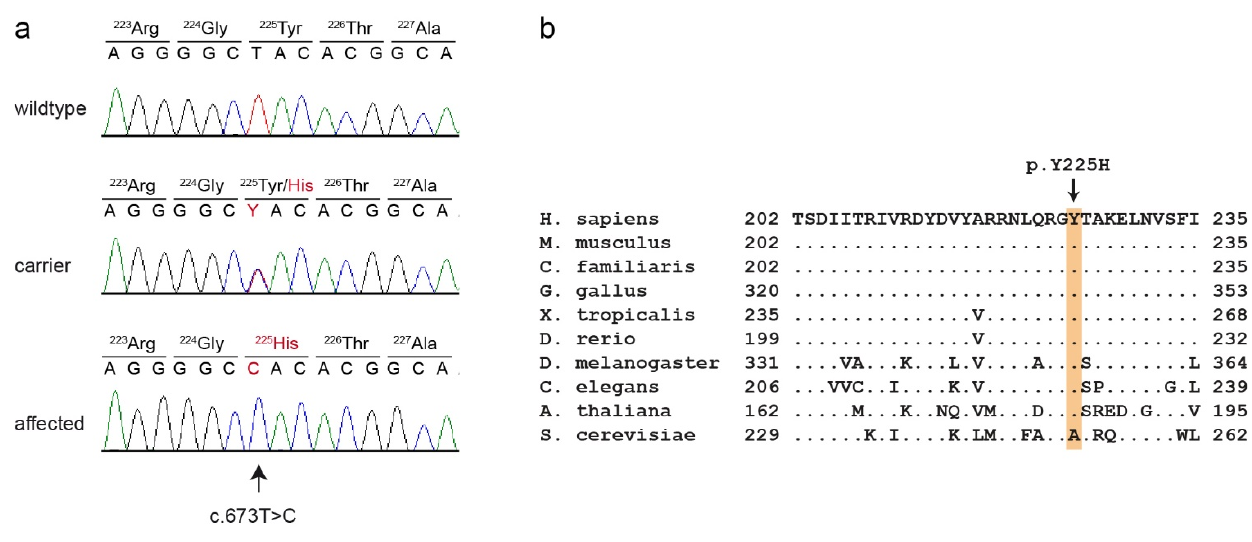
Figure 4. Details of the PCYT1A :c.673T>C variant. ( a ) Representative electropherograms of three dogs with different genotypes are shown. The variable position is indicated by an arrow. The altered base and the altered amino acid translation are indicated in red. ( b ) Multiple-species alignment of the PCYT1A amino acid sequences in the region harboring the p.Y225H variant. The variant affects a highly conserved tyrosine residue. Accession numbers: human ( Homo sapiens ) NP_001299602.1; mouse ( Mus musculus ) NP_034111.1; dog ( Canis lupus familiaris ) XP_038439059.1; chicken ( Gallus gallus ) XP_046754443.1; frog ( Xenopus tropicalis ) XP_031758151.1; zebrafish ( Danio rerio ) NP_001017634.1; fly ( Drosophila melanogaster ) NP_647621.1; worm ( Caenorhabditis elegans ) P49583.2; Arabidopsis ( Arabidopsis thaliana ) Q42555; yeast ( Saccharomyces cerevisiae )